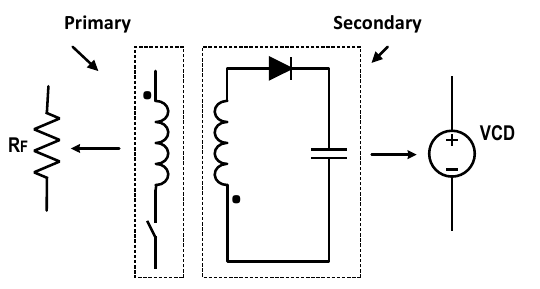
Figure 2. Flyback model in DCM for the low frequency averaging analysis (LFAA).